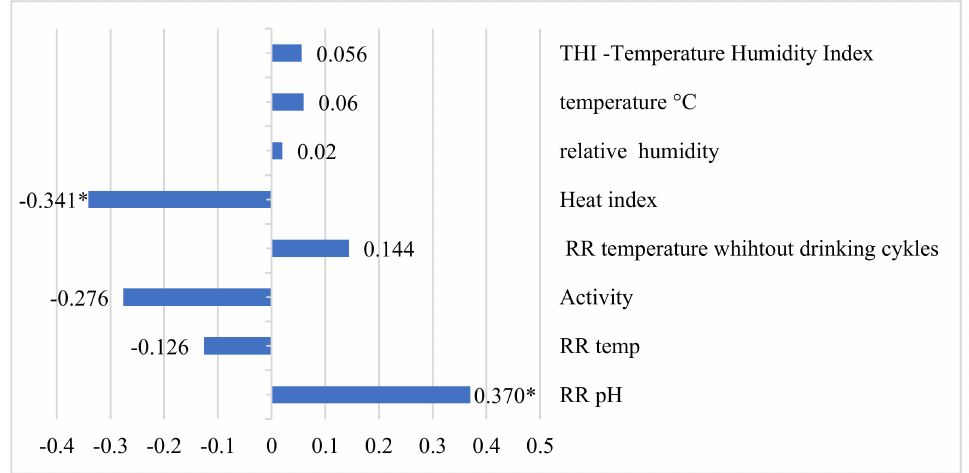
Figure 2. Correlation coefficients between methane, temperature humidity index, and reticulorumen indicators. * p < 0.05. CH 4 —methane; RR—reticulorumen. For the temperature–humidity index, we found a highly positive statistically signif- icant relationship with temperature (r = 0.995, p < 0.001), a somewhat positive relation- ship with relative humidity (r = 0.598, p < 0.001) and a highly negative relationship with RR pH (r = − 0.717, p < 0.001) (Figure